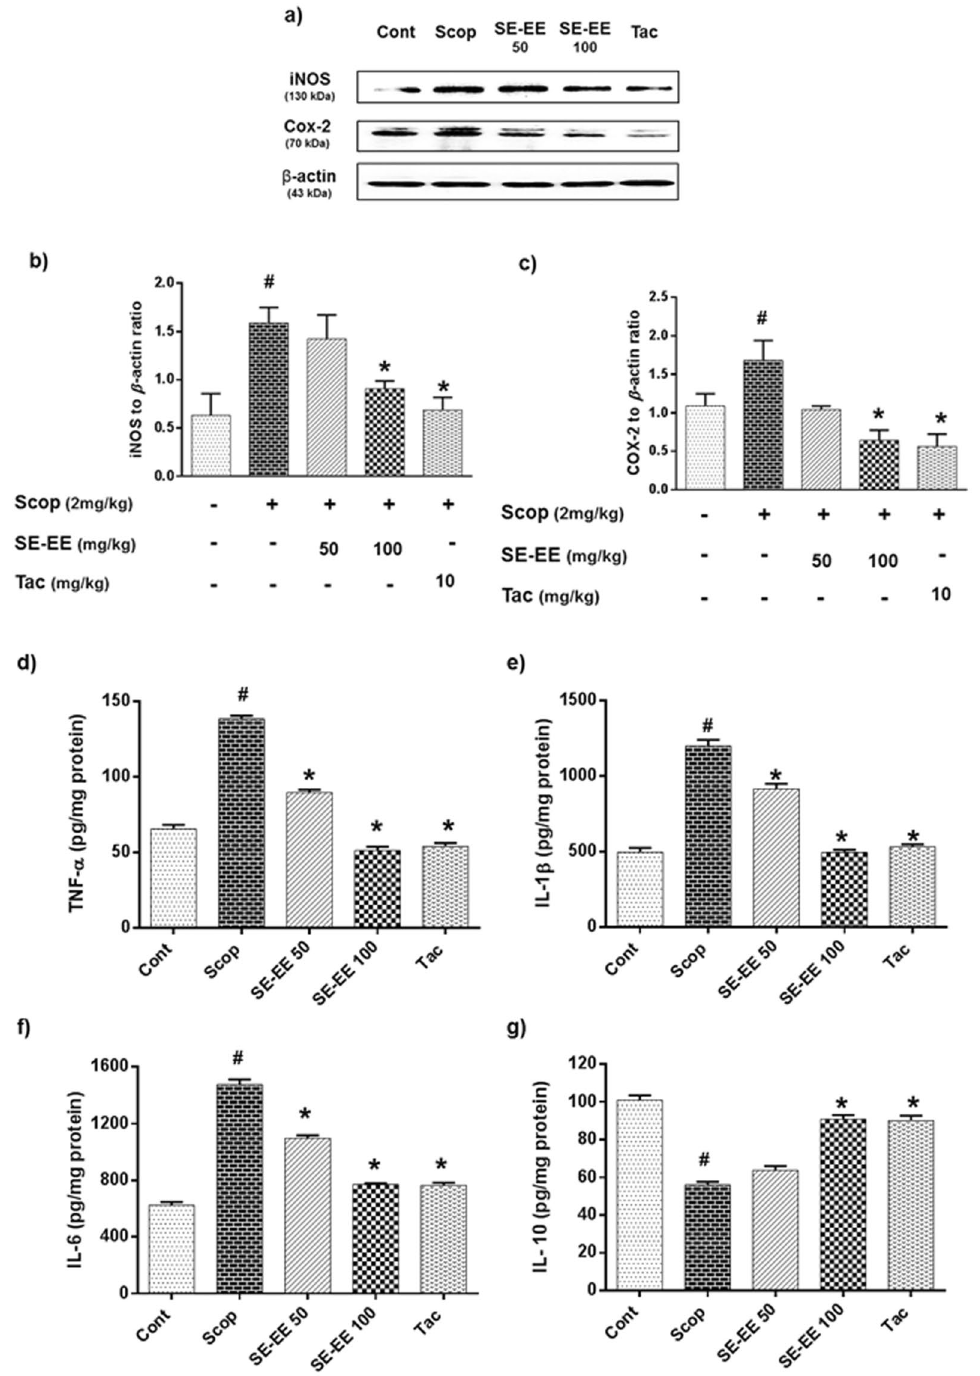
Figure 6. Effects of SE-EE on scopolamine inflicted neuroinflammation in C57/BL6N mice: ( a ) iNOS and COX-2 protein expressions in the hippocampus (n = 3) was determined by western blotting analysis (respective markers were acquired by cropping from the same gel, full length blots are in Supplementary data- S.3.2) and ( b , c ) represents the quantification of inflammatory protein expression relative to β -actin, which was achieved using the ImageJ software; ( d , e , f and g ) represent the level of TNF- α , IL-1 β , IL-6 and IL-10 proteins in the hippocampus (n = 5, pooled biological replicates), respectively, as acquired via ELISA. Data are expressed as mean ± SD. One-way ANOVA-Tukey’s multiple comparison test was performed. # p < 0.05 compared with the control group; * p < 0.05 other treated groups compared with the scopolamine